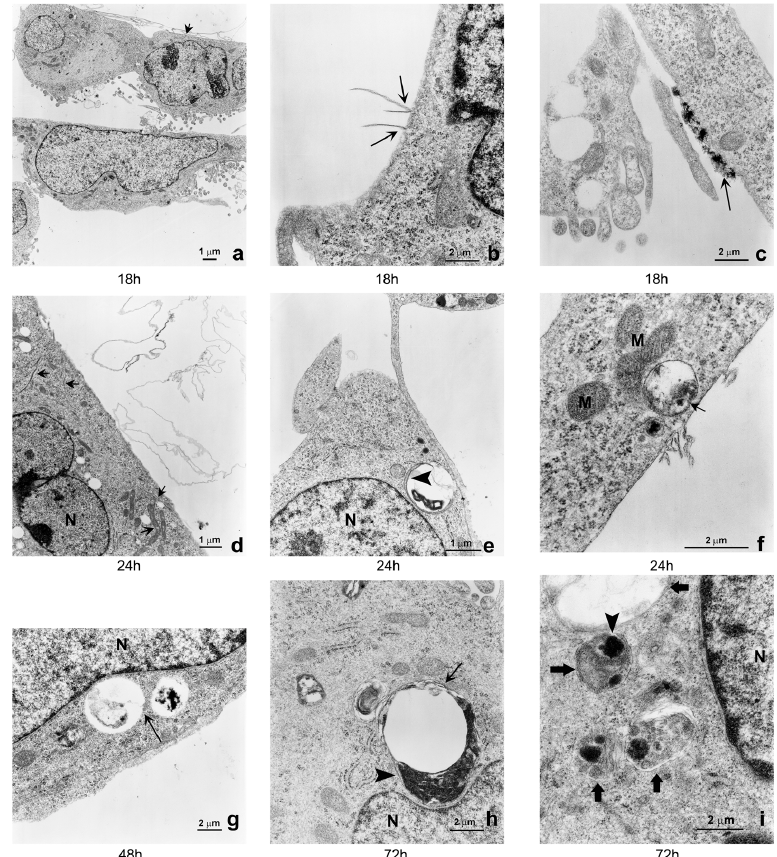
Figure 2. TEM images of GO-treated SK-N-BE(2) cells: ( a ) S K-N-BE(2) cells at low magnification showing normal nuclear and cellular morphology. No signs of ultra-structure alteration of sub-cellular compartments are visible. Interaction of GO nanoribbons with plasmamembrane are visible in the upper part of the image (arrow) (magnification 3800×); ( b ) Single GO nanoribbons interaction (arrow) with SK-N-BE(2) plasmamembrane after 18 h of exposure. Note the perpendicular orientation of GO (magnification 21,000×); ( c ) Large amounts of GO nanoparticles (arrow) interacting with the plasmamembrane and appearing like electron dense aggregates (magnification 21,000×); ( d ) Graphene single nanoribbons are present inside cytoplasm (arrows) after 24 h of exposure (magnification 6600×). The image shows the presence of fused mitochondria (arrow); ( e ) Autophagosome (double membrane is showed by arrowhead) containing graphene visible like electron dense structure and localized inside the cell near the plasma membrane of SK-N-BE(2) cells after 24 h of incubation (magnification 11,500×); ( f ) Phagosome vacuole containing GO aggregates and localized near the plasmamembrane (arrow). Note the presence of GO sheets still interacting with the plasmamembrane (arrowhead) (magnification 39,000×); ( g ) SK-N-BE(2) at 48 h of GO exposure showing phagosomes vacuoles adjacent to the nuclear membrane (arrow) (magnification 15,500×); ( h ) autophago-lysosome with double membrane (arrow) and containing a large amount of graphene aggregates close to the nuclear membrane (arrowhead) (magnification 21,000×); ( i ) Seventy-two hours of exposure to GO (28,500×) induced autophagosomes accumulation (28,500×). The image shows an increased number of autophagosomes containing electron dense GO aggregates (arrowhead) and with evident double membranes (arrows). Images were taken by using a Philips CM-10 Transmission Electron Microscopy as described under Materials and Methods. N = nucleus; M = mitochondria.